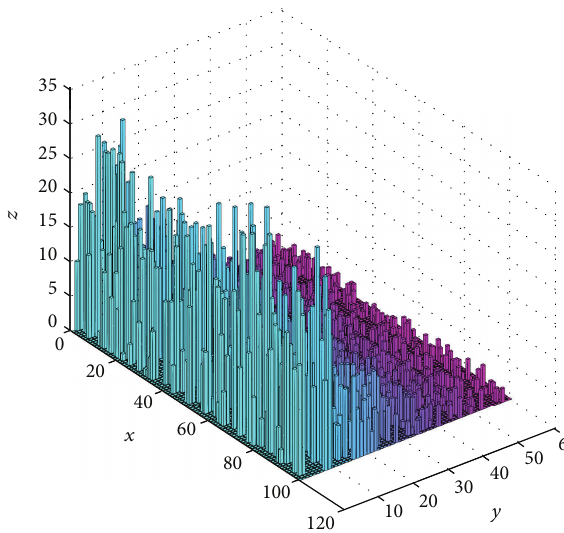
Figure 9: Feature points and characteristic